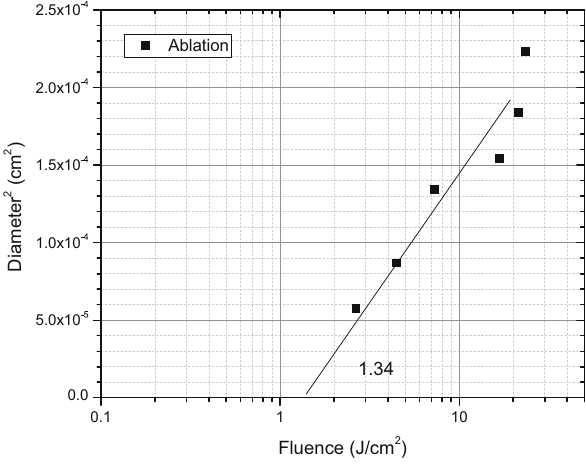
Figure 6: The threshold laser fl uence for removal of ITO from glass by 266 nm, ns laser.